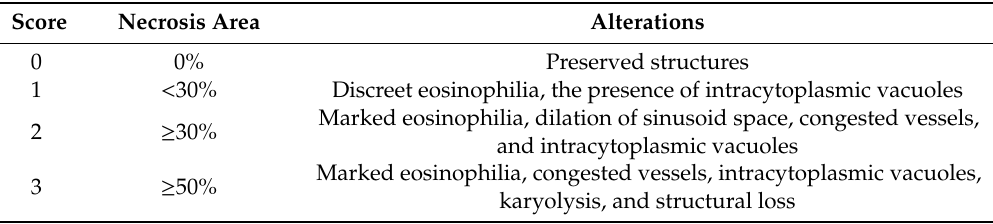
Table 6. Score levels’ classification considering the area of necrosis and hepatic alterations previously established by Silva et al. (2014)